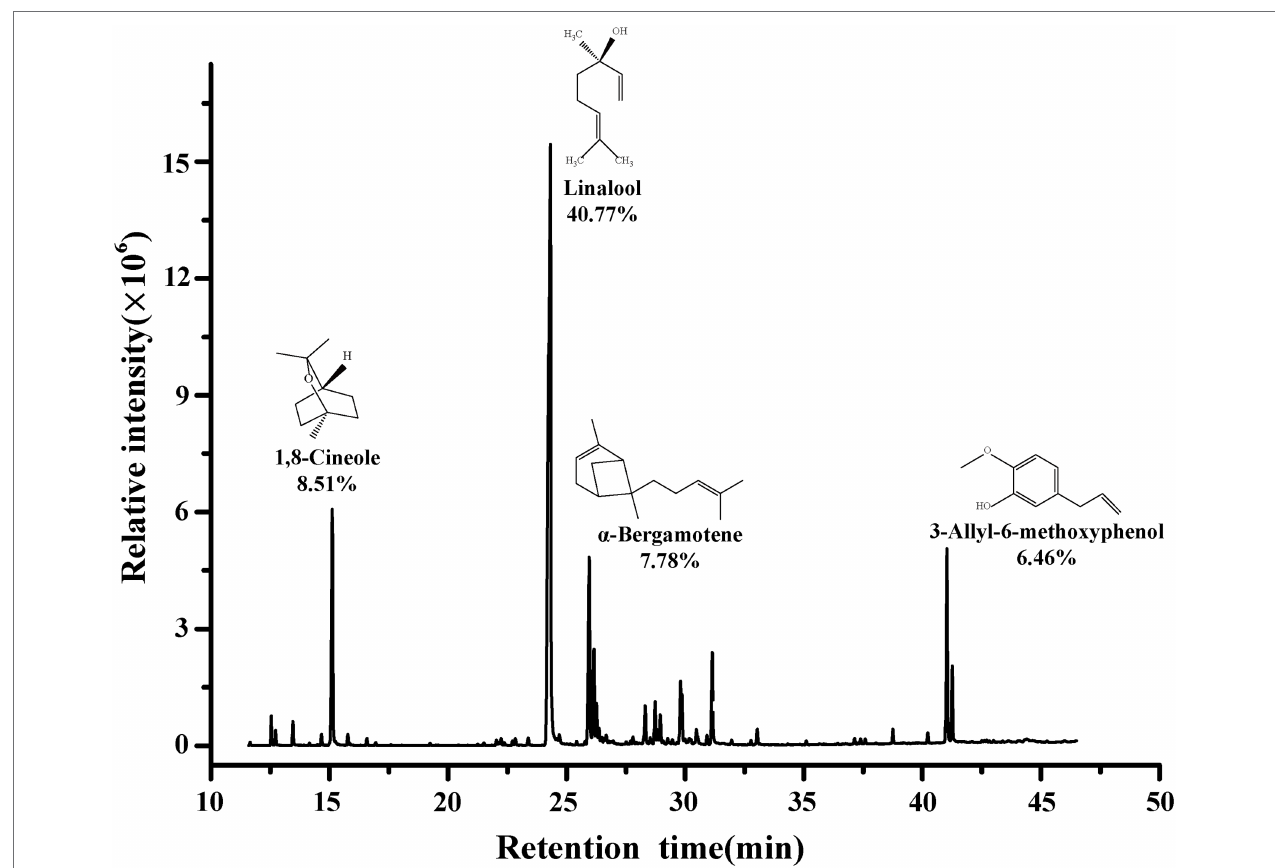
FIGURE 1 | Chemical composition of